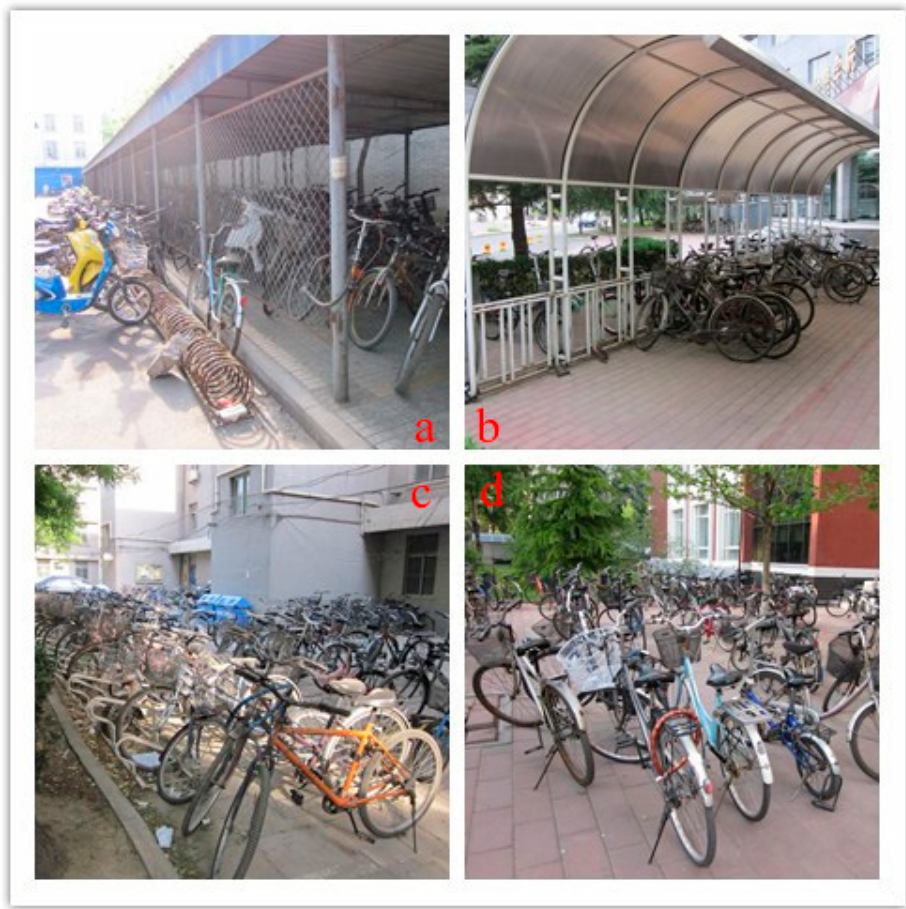
Figure 2. Four types of bicycle parking spots on campus. ( a ) With bicycle lockers/racks, a shed and bicycle services (pump and bicycle repair service). ( b ) With bicycle lockers/racks and a shed, but no bicycle services. ( c ) With bicycle lockers/racks, but no shed or bicycle services. ( d ) Without bicycle lockers/racks, a shed or bicycle services.